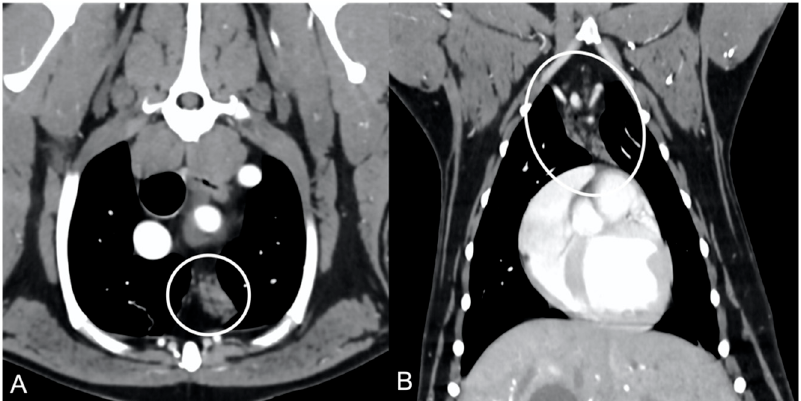
Figure 5. Appearance of the thymus (circled) in an adult dog. Post-contrast transverse CT image ( A ) and dorsal reconstruction ( B ). Note the presence of multiple hypoattenuating septi within the parenchyma, giving the thymus a lobulated appearance and overall low attenuation.